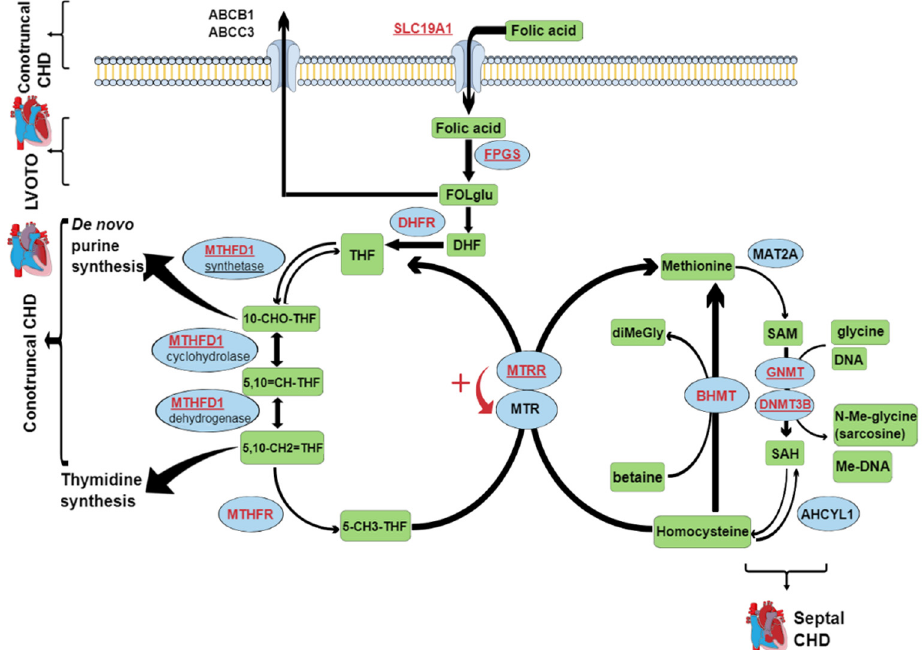
Figure 1. The folate metabolic pathways. Blue ellipses, enzymes; green rectangles, metabolites; written in red, names of genes selected for genotype analysis; underlined, genes that showed a significant association with certain types of CHD (contruncal, septal, and LVOTO). ABCB1, P-glycoprotein; ABCC3, multidrug resistant protein 3; SLC19A1 ; solute-carrier family 19; FPGS , folypolyglutamyl synthase; FOLglu, polyglutamylated folic acid; DHF, dihydrofolate; DHFR , dihydrofolate reductase; THF, tetrahydrofolate; MTHFD1 , trifunctional methylenetetrahydrofolate dehydrogenase/cyclohydrolase/synthase; 10-CHO-THF, 10-formyl tetrahydrofolate; 5,10 = CH-THF, methenyl tetrahydrofolate; 5,10-CH2 = THF, methylene tetrahydrofolate; 5-CH3-THF, 5-methyl tetrahydrofolate; MTR, 5-methyl tetrahydrofolate-homocysteine methyltransferase; MTRR , 5-methyl tetrahydrofolate-homocysteine methyltransferase reductase; MAT2A , methionine adenosyltransferase II alpha; SAM, S-adenosylmethionine; SAH, S-adenosylhomocysteine; GNMT , glycine N-methyltransferase; DNMT3B , DNA (cytosine-5-)-methyltransferase 3 beta; ACHYL1 , S-adenosylhomocysteine hydrolase-like 1; BHMT , betaine-homocysteine S-methyltransferase; diMeGly, dimethylglycine; Me, methyl; LVOTO, left ventricular outflow tract obstruction; CHD, congenital heart defect.